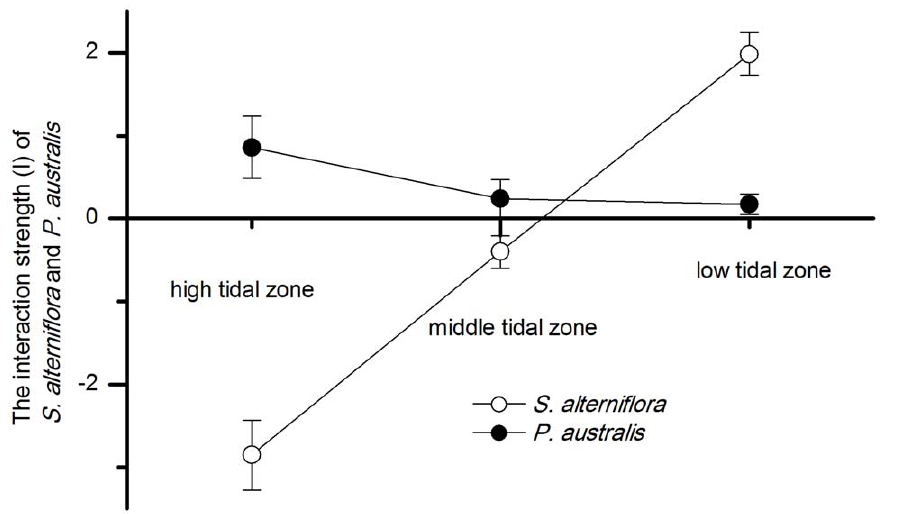
Figure 5. The interaction strength (I) of P.australis and S.alterniflora along the tidal gradient. The performance of targets was measured by the relative growth rate per day